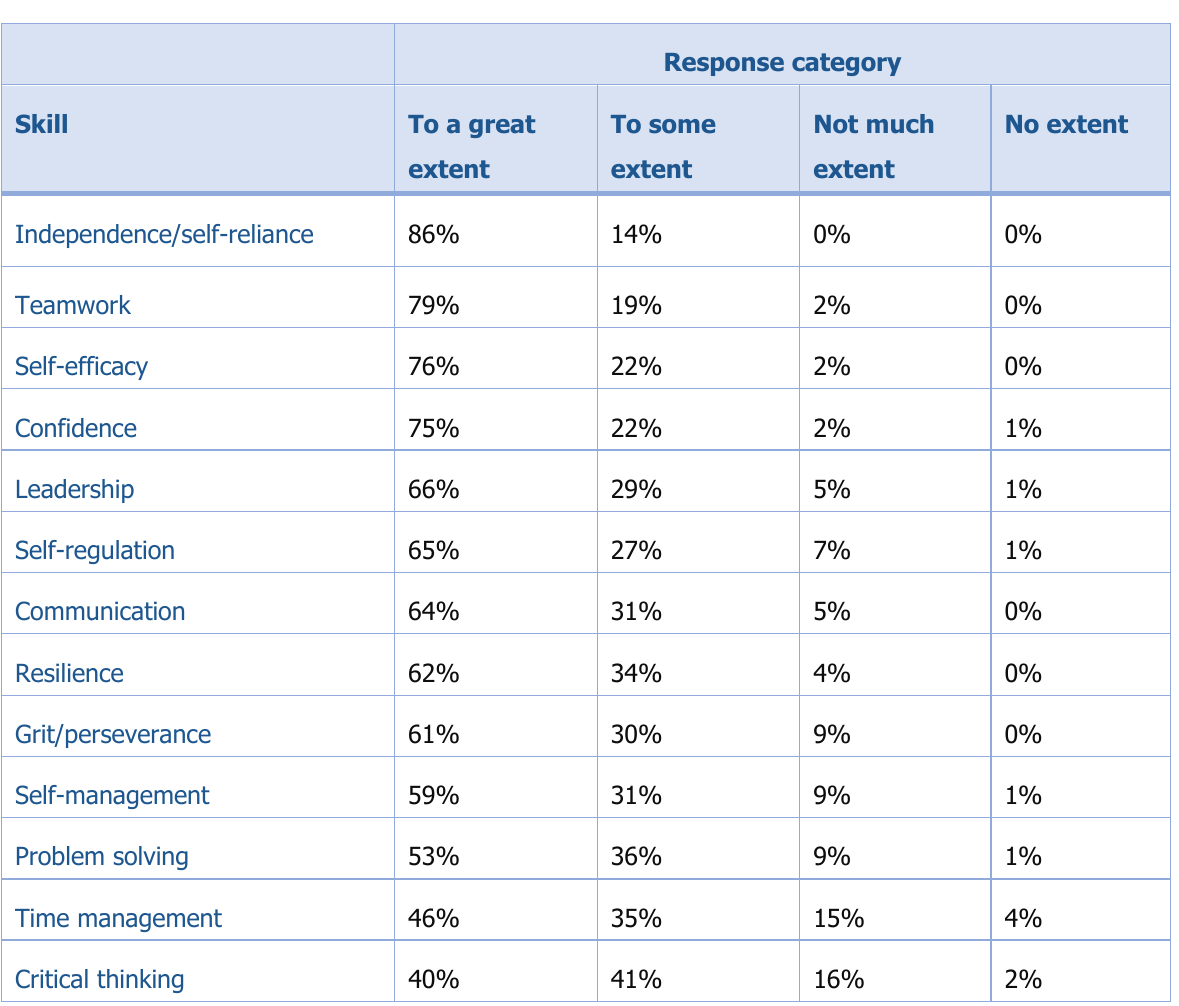
Table 1. College Readiness Skills Reported in Percentage for Women: Highest Reported to Lowest Reported (n =